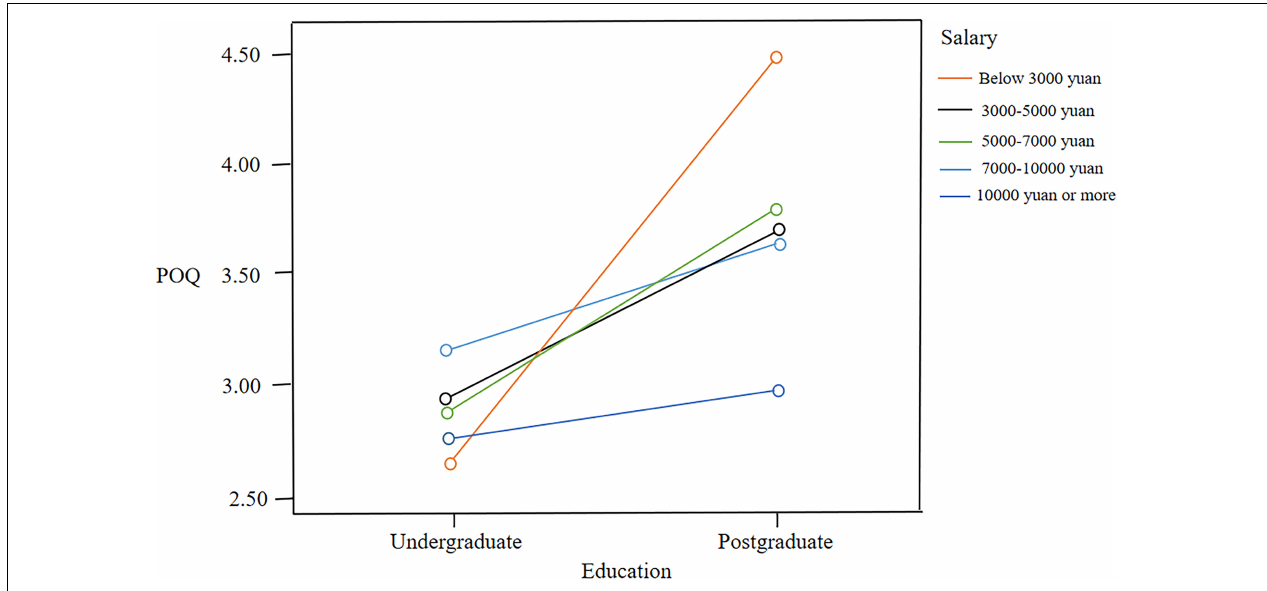
FIGURE 2 | The interaction of education and income on POQ.